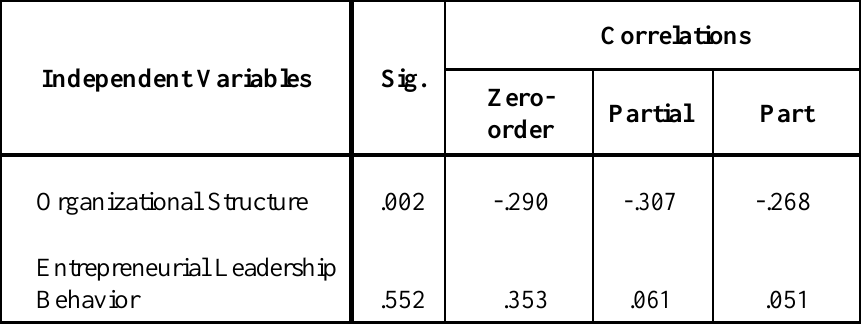
Where; Significant at